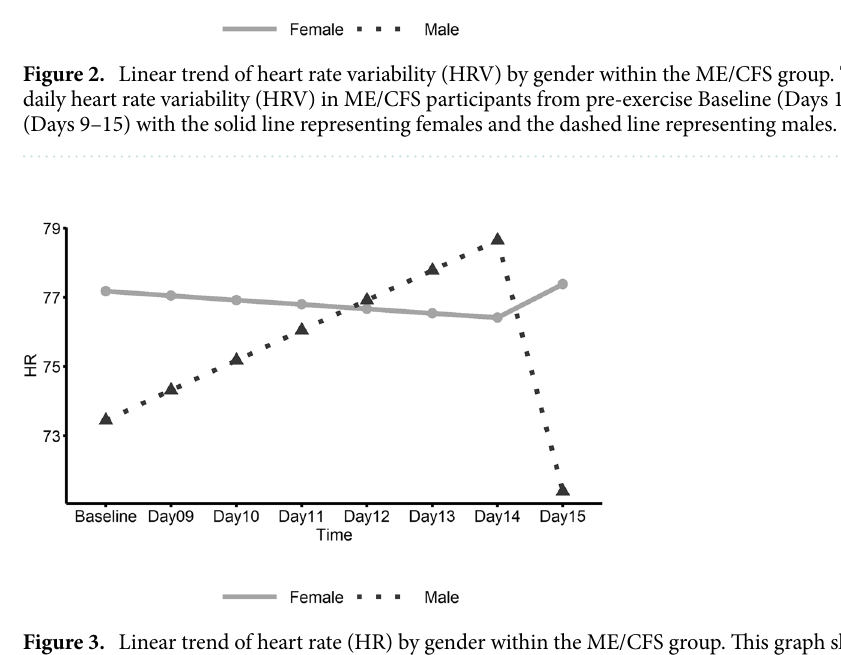
Figure 3. Linear trend of heart rate (HR) by gender within the ME/CFS group. This graph shows daily heart rate (HR) in ME/CFS participants from pre-exercise Baseline (Days 1–8) to follow-up (Days 9–15) with the solid line representing females and the dashed line representing males.